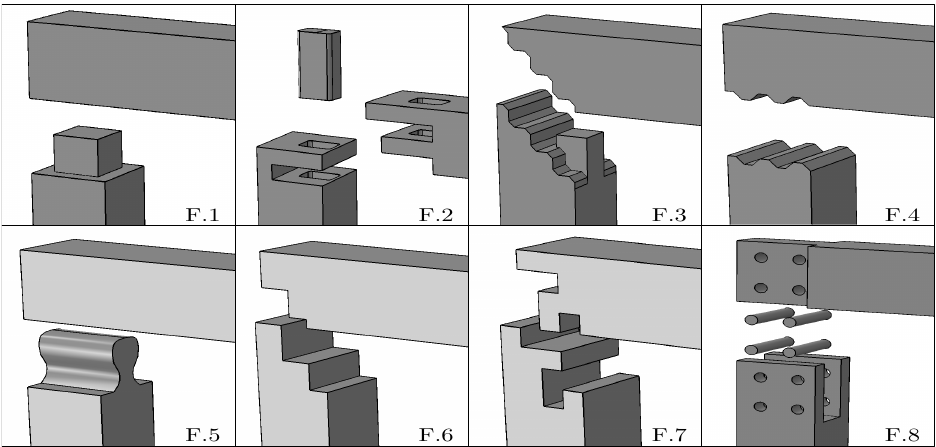
Figure 2. Geometry of the proposed and evaluated dry concrete connections and